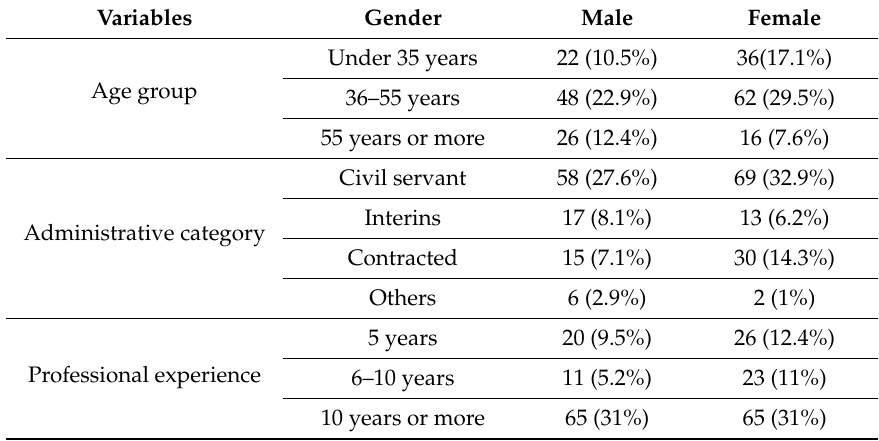
Table 1. Sample distribution according to sociodemographic variables and